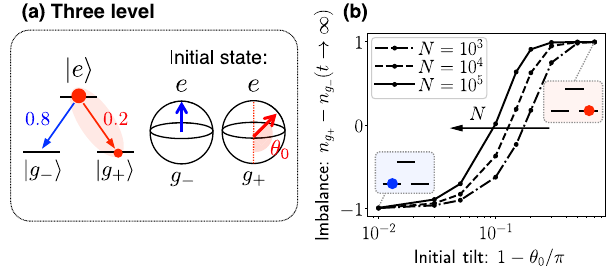
FIG. 7. Clebsch-Gordan coefficients vs initial coherences. (a) Three-level toy model with two ground states g and one (cid:2) 0 . 8 and excited state e . The single-particle decay rates p e → g − ¼ 0 . 2 correspond to the j g p and j e − 1 states of the i e → g þ ¼ = 2 i V (cid:2) 1 = 2 V ð F g ; F e Þ ¼ ð 1 = 2 ; 3 = 2 Þ level structure. The initial state is a superposition of j e i and j g i , which we depict through the þ corresponding ð e; g − Þ and ð e; g Þ (normalized) Bloch vectors. þ Only the latter Bloch sphere has nonzero initial coherences − captured by the polar angle θ 0 . (b) Population imbalance n g þ n between the two ground states obtained as t → ∞ as a g − function of the initial tilt θ 0 for different atom numbers N computed with TWA for 10 4